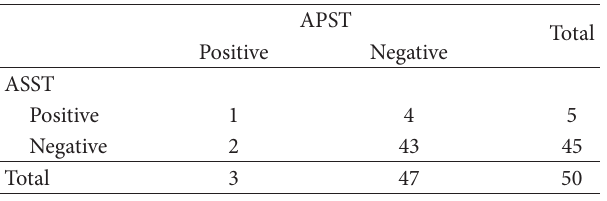
Table 3: The distribution of ASST and APST results of the control